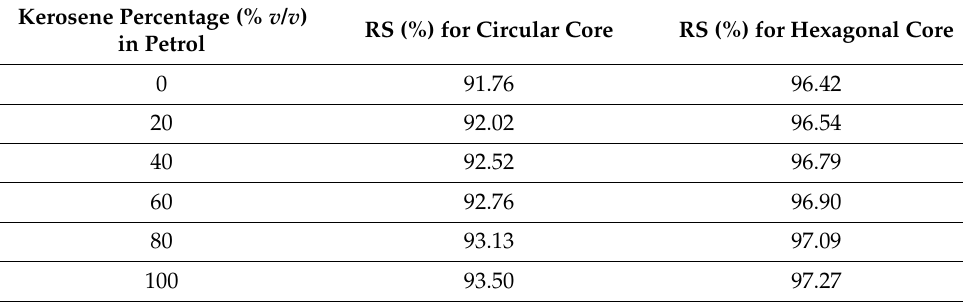
Figure 9. RS variation with the change of frequency for D = 643.34 μ m, D c = 280 μ m, t = 15 μ m, z = 10 μ m. Table 3. RS of the proposed sensor at optimum design